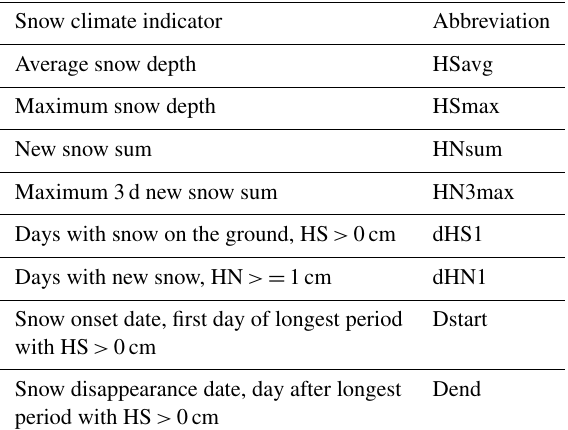
Table 1. Definitions and abbreviations of the investigated snow cli- mate